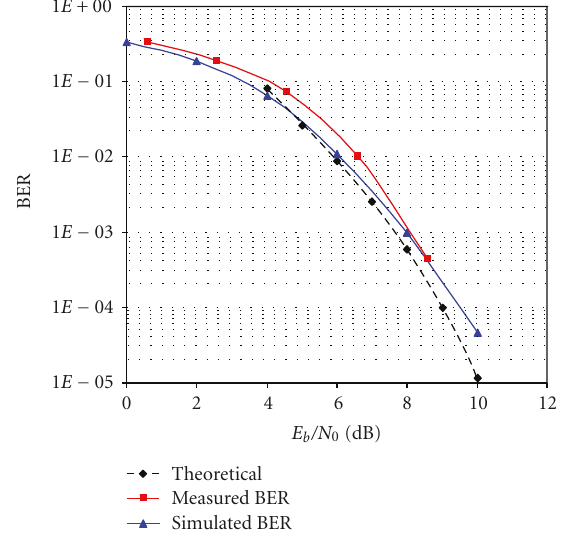
Figure 5: 802.11b AWGN compared